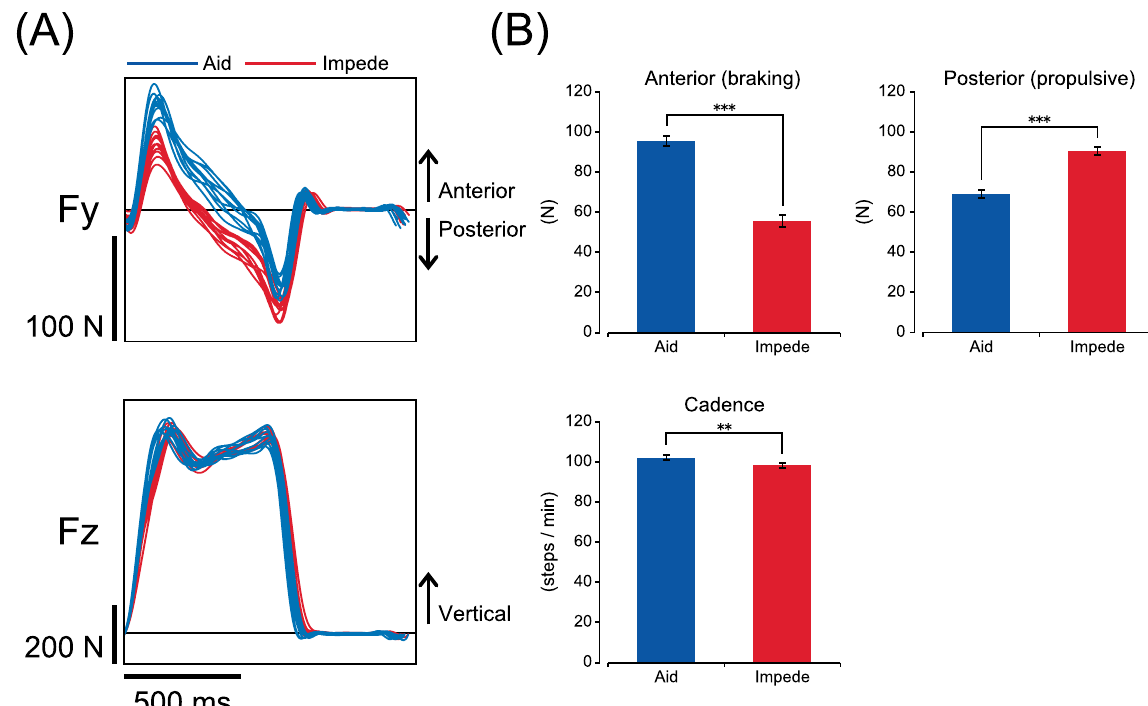
Figure 2. ( A ) Representative examples of the anteroposterior GRF (N) and the vertical GRF (N) during baseline with exposure to different force fields. Each set of waveforms represents the time-series changes of the force for ten consecutive stride cycles (from heel contact to subsequent heel contact and including both left and right sides, superimposed) in a single subject. The blue and red lines represent walking with an aiding force field and an impeding force field, respectively. The calibration bars indicate 100 N (Fy), and 200 N (Fz) for the vertical axis and 500 ms for the horizontal axis, respectively. ( B ) Mean amplitude (absolute) of each GRF component tested during the baseline with different force fields. The error bars represent the SEM. Statistically significant differences: **P < 0.01, ***P < 0.001, n =